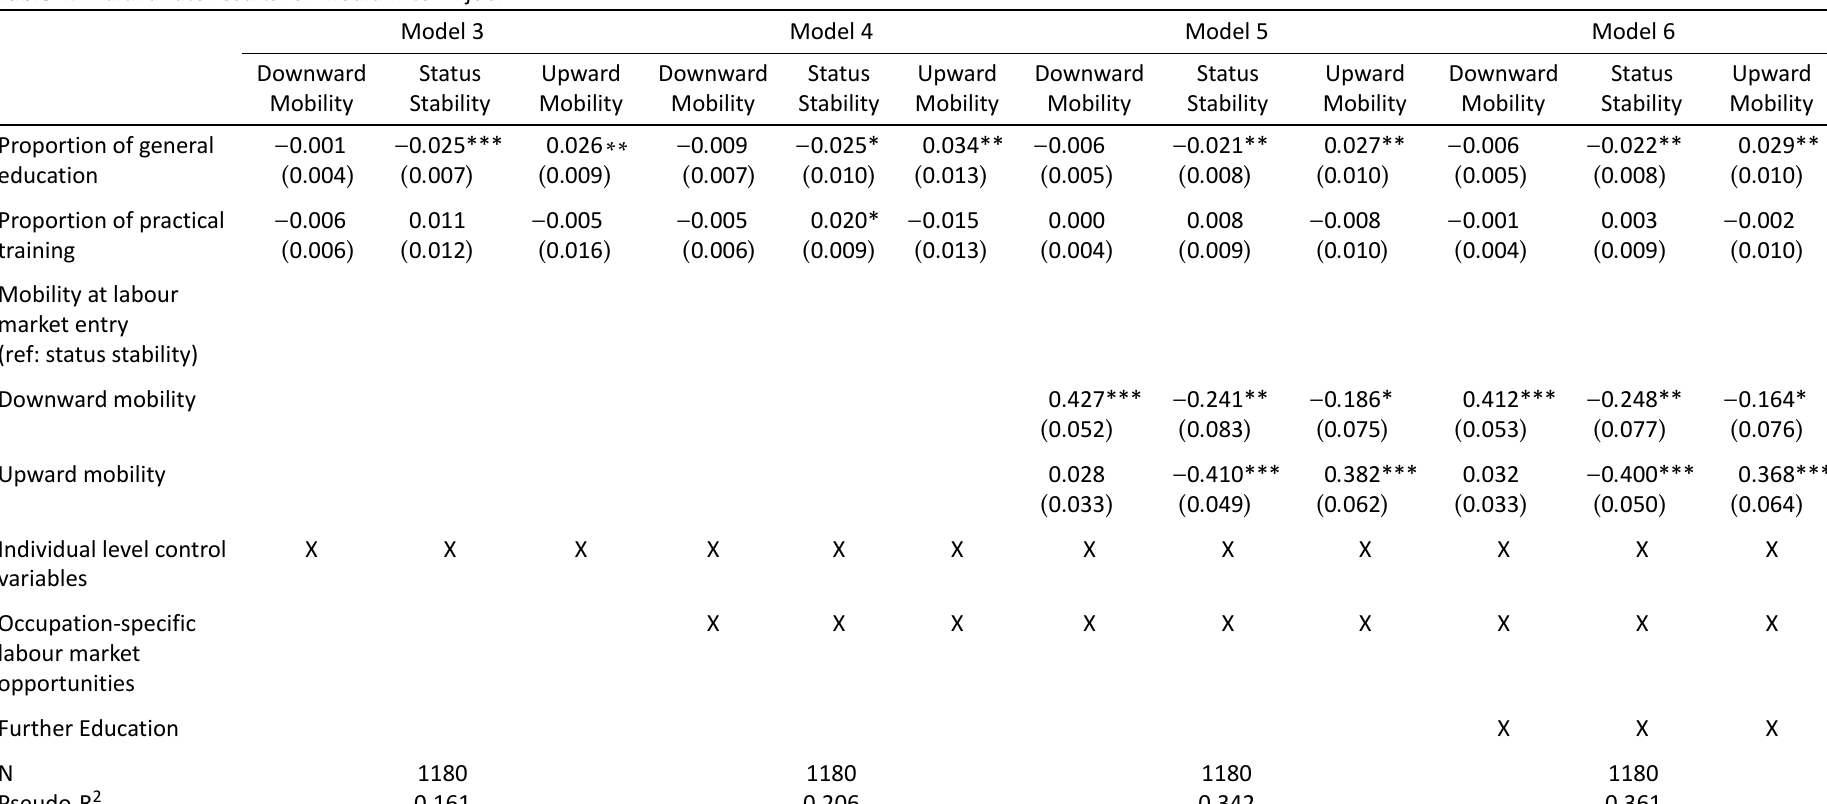
Table 4. Multivariate results for medium‐term